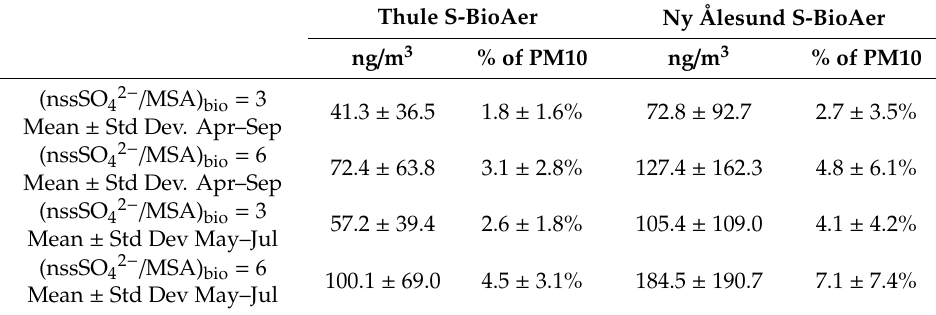
Table 1. Biogenic aerosol (S-BioAer), mean content (and its standard deviation), and contribution to PM 10 at Thule and Ny Ålesund during the periods April–September and May–July. The values are calculated considering the values 3 and 6 for the (nssSO 42 − / MSA) bio ratio in Equation (1). Thule S-BioAer Ny Ålesund